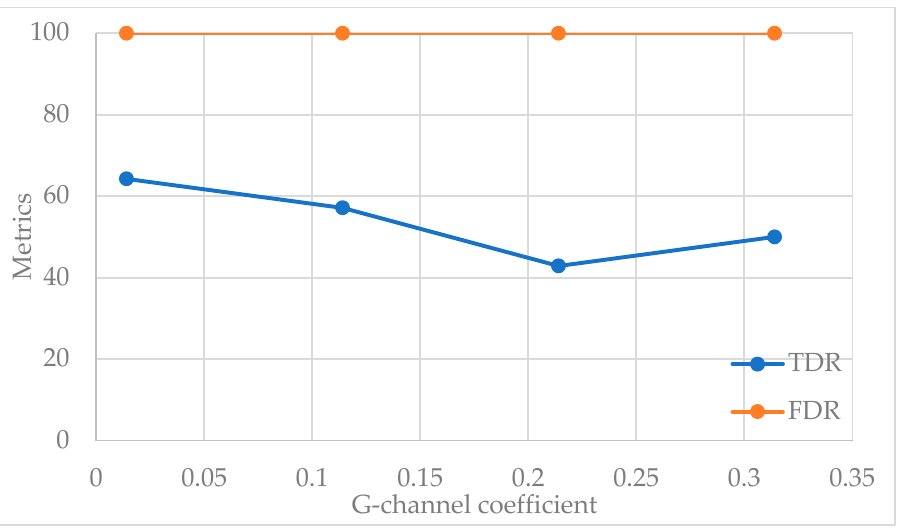
Figure 6. Graph of B-channel coefficients versus detection accuracy.